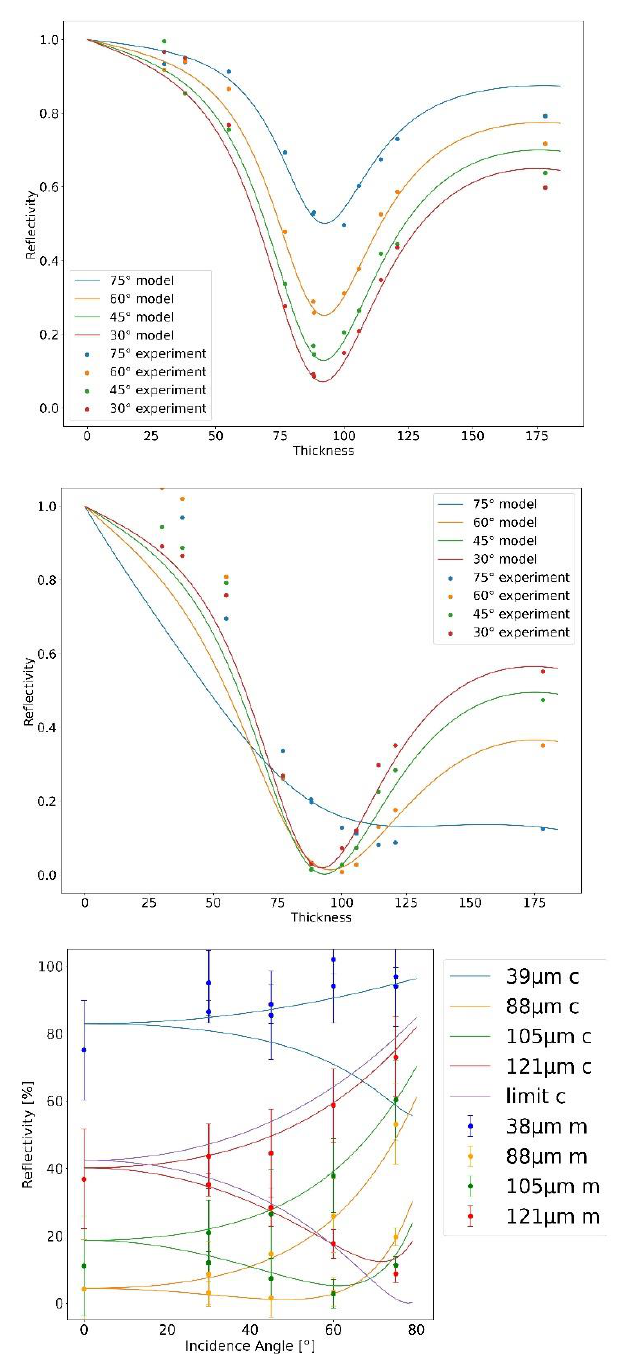
Fig. 3. Thickness dependency of the reflectivity for orthogonal and parallel polarization respectively, additionally the incidence angle dependency. The points are the measured values, the lines the respective calculated